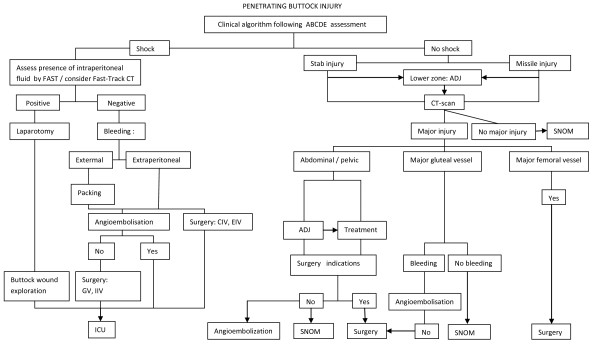
Algorithm for management of penetrating trauma to the buttock. FAST - Focused assessment with sonography for trauma. SNOM - Selective non-operative management. SE - Serial examination. ADJ - Adjuncts. Surgery indications: haemoperitoneum, injury of major or junctional vessel (CIV, EIV), perforation of bowel, peritonitis, not-stable bony pelvis, sciatic nerve transsection, necrotic/dirty soft tissue, urethra/ureter transsection, intraperitoneal bladder rupture (consider on individual basis). CIV - common iliac vessel. EIV - external iliac vessel. IIV - internal iliac vessel. ICU - Intensive care unit